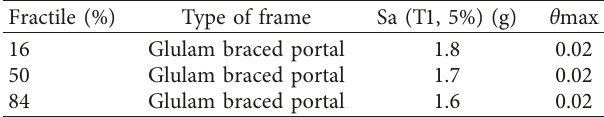
Table 11: Summarized capacity of the glulam braced portal frame for immediate occupancy (IO) limit state.